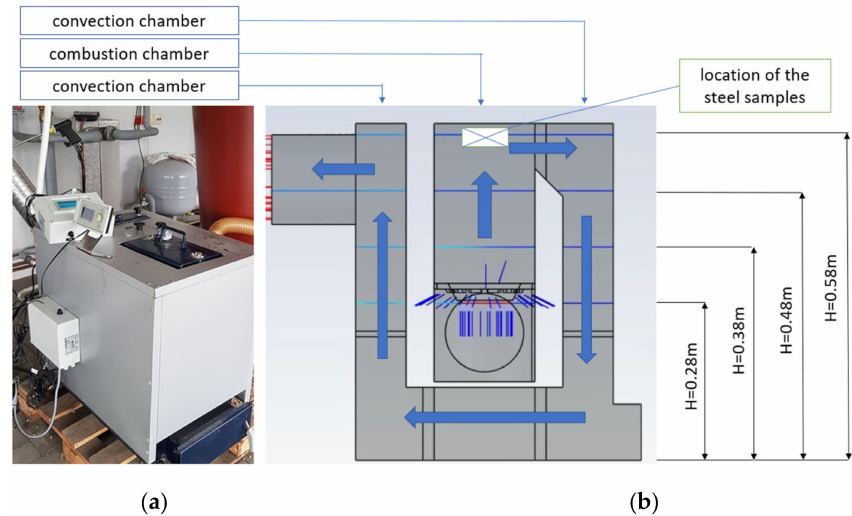
Figure 6. View of the boiler: ( a ) The boiler on the test stand; ( b ) Combustion chamber with marked key levels for further analysis of the